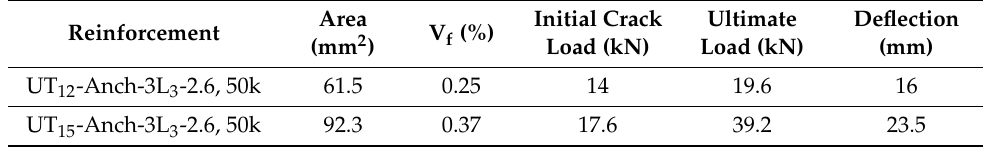
Table 10. Effects of the variation in cross-section area on the performance of TRC